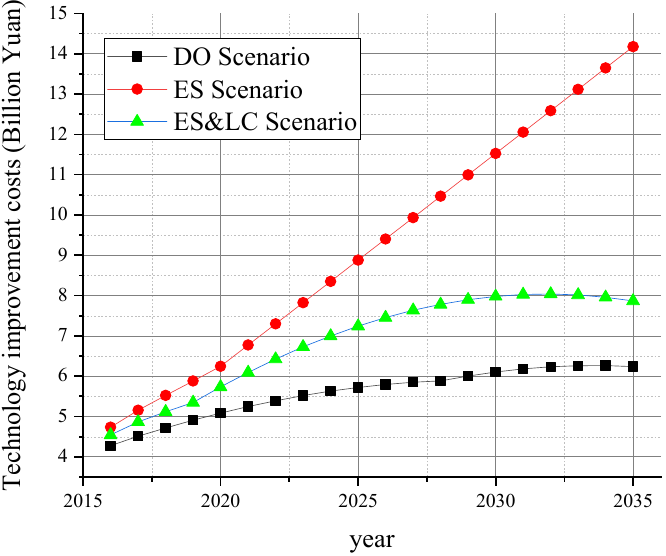
Figure 3. Technology improvement costs of the DO ES and ES&LC scenarios.